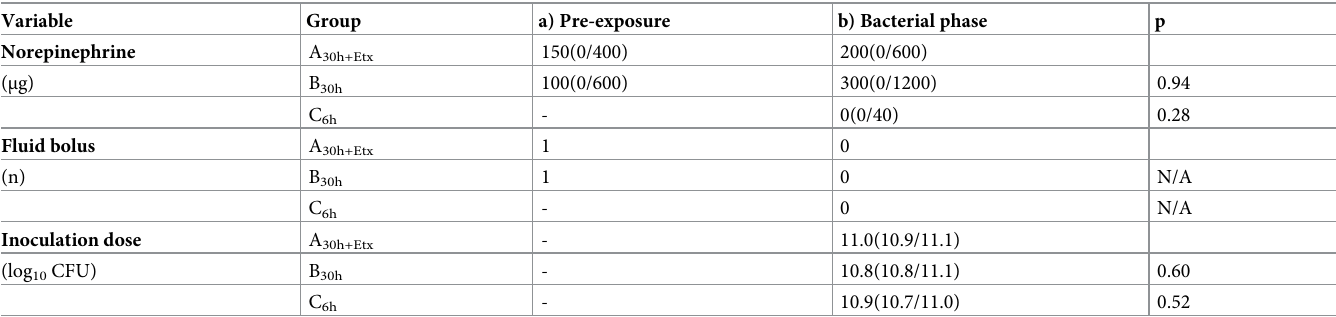
Table 1. Norepinephrine, fluid, inoculation